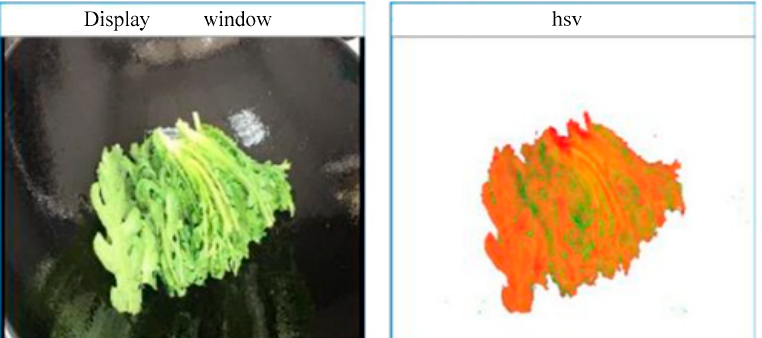
Figure 2. Foreground segmentation (( left ) is the original image, ( right ) is the false color operation image after HSV conversion).